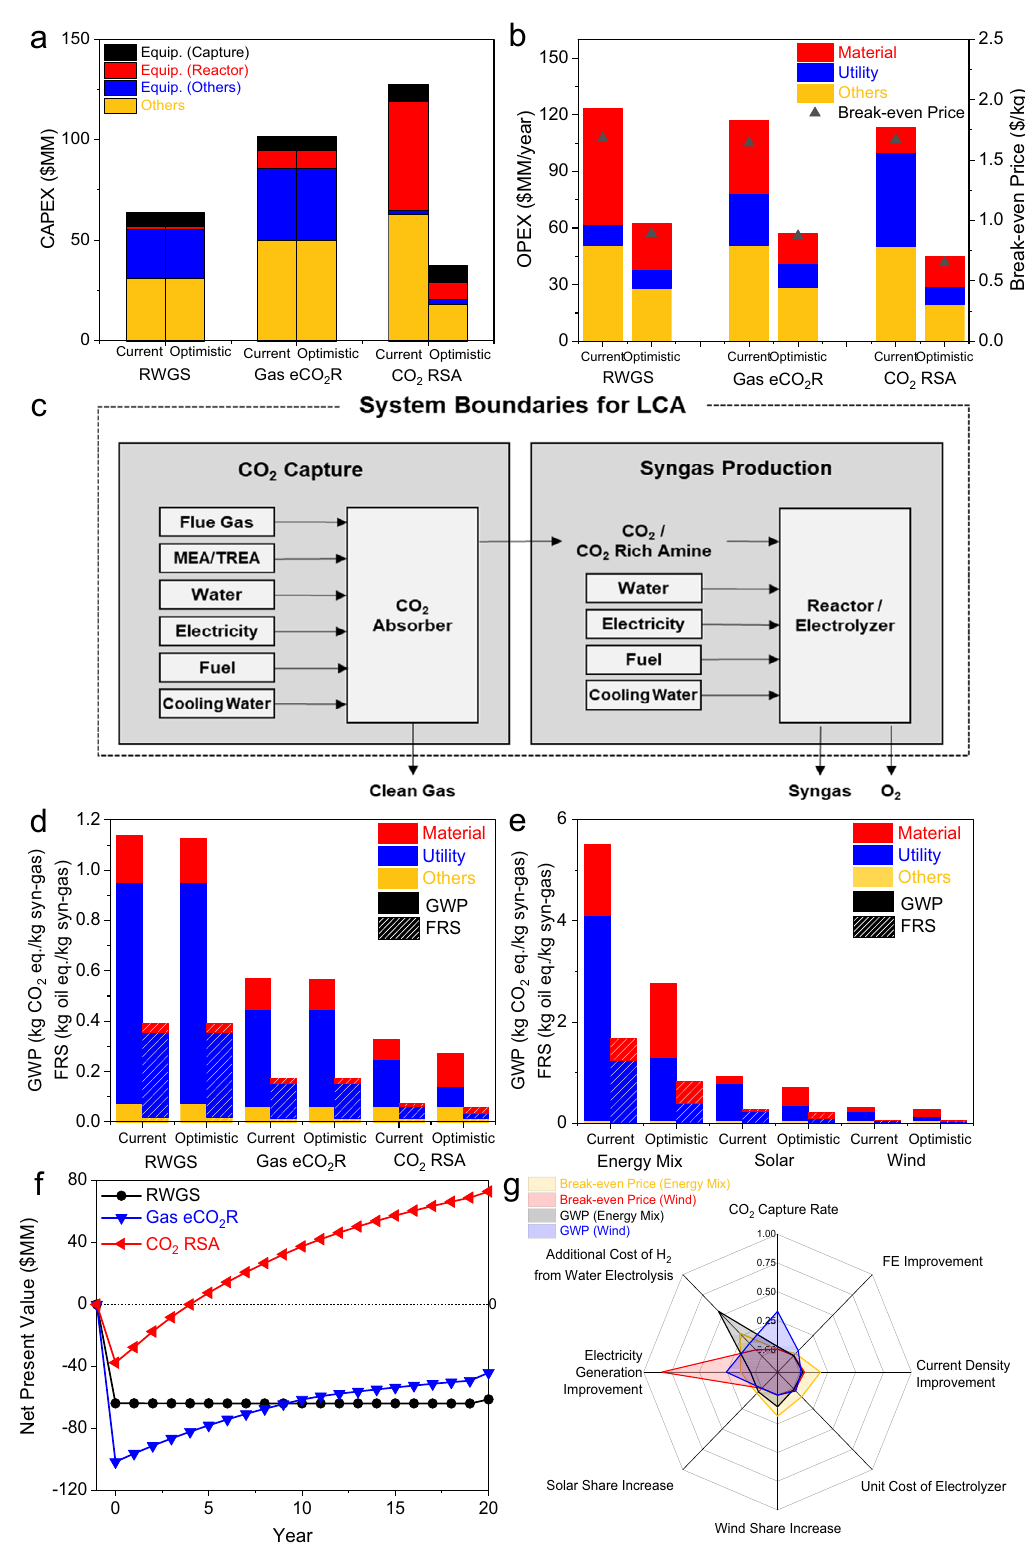
Fig. 4 | Results of TEA, LCA, and GSA for the wind case. a Capital expenditures for three processes. b Operating expenditures and break-even prices for syngas from the three processes. c Graphical representation of LCA system boundaries. d LCA results for the three processes. The left and right bars in each scenario